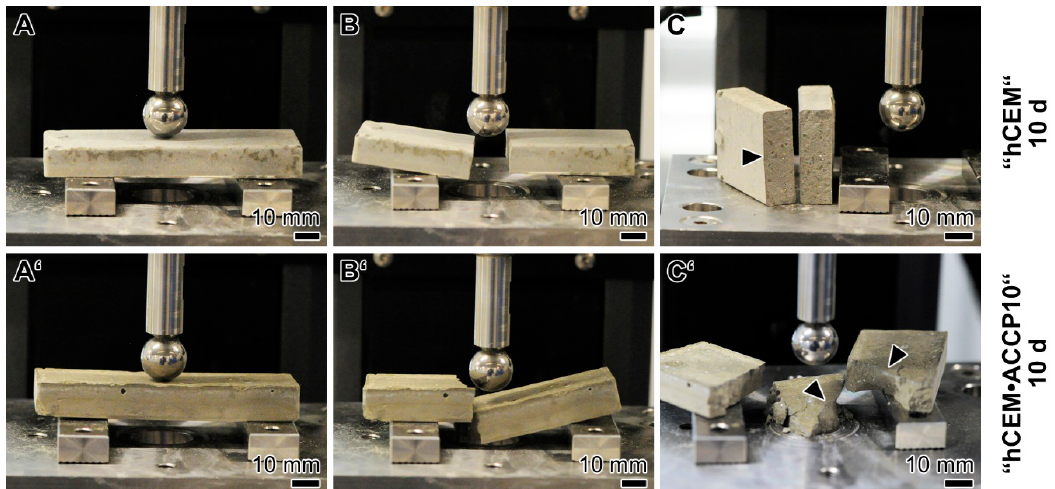
Figure 7. Three-point bending system applied to assess the resistance of the control cement “hCEM” ( A – C ) in comparison to the “hCEM•ACCP10” material ( A’ – C’ ). During the bursting phase, a sharp breaking plane is seen in the controls ( C ; arrowhead), while in the “ACCP10”-supplemented material ( C’ ; arrowheads) the block bursts into several pieces with different sizes.